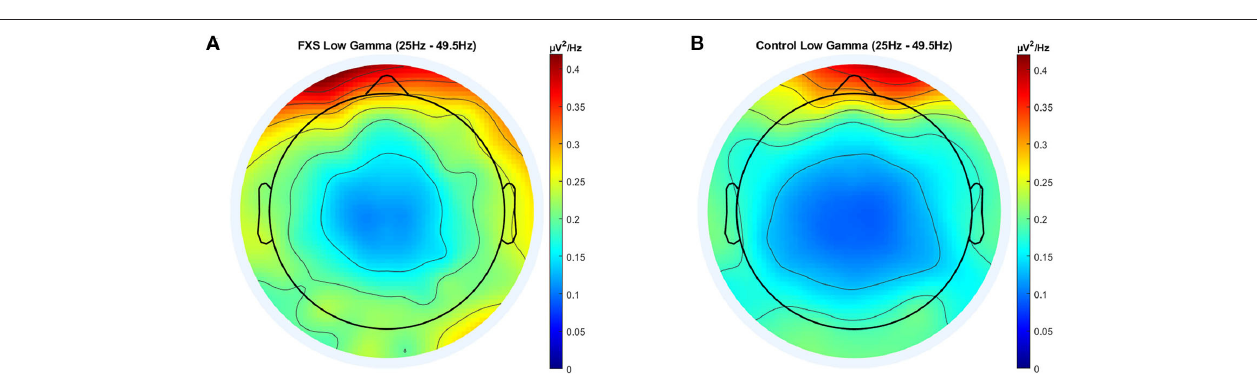
FIGURE 4 | Topographic representation of average power spectral density in the FXS (A) and control (B) group for the low gamma band (25–49.5Hz).